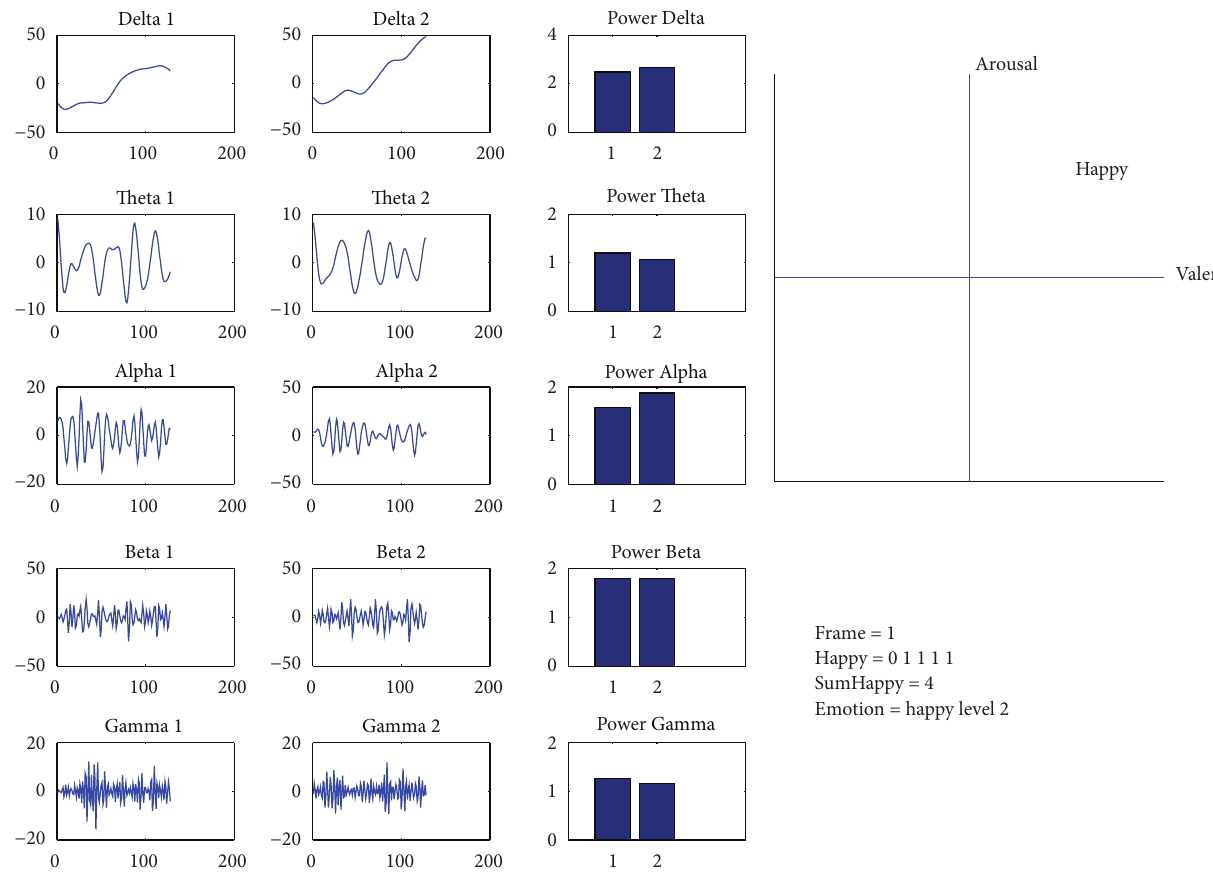
Figure 11: Screenshot of real-time happiness detection system.